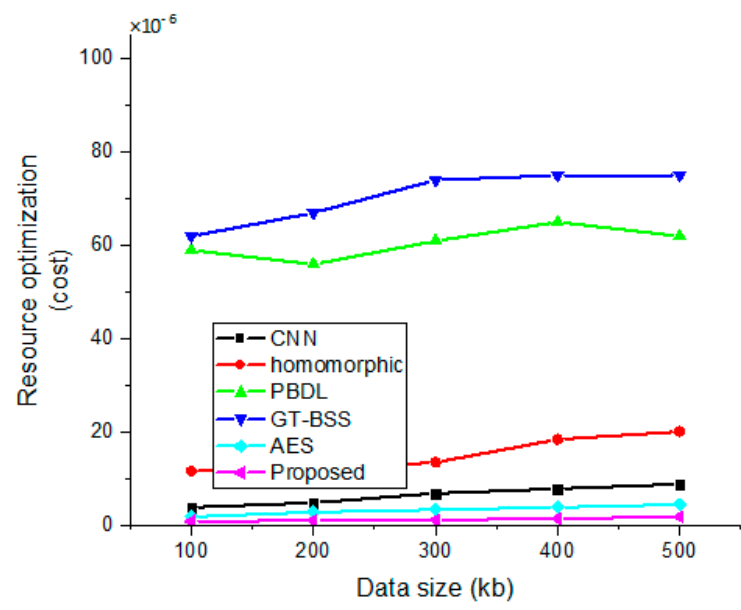
Figure 10. Correlation between data size and resource optimization.